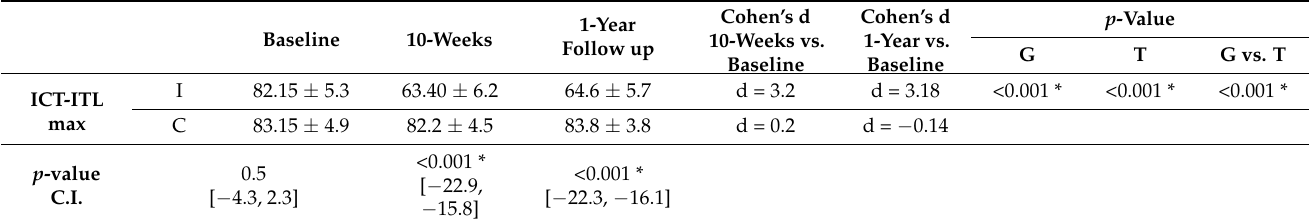
Table 2. The changes in sagittal alignment management outcomes in experimental and control groups vs. time. Kyphotic angle ICT-ITL max = angle of kyphosis between tangents of cervicothoracic junction (ICT) and of thoracolumbar junction (ITL). Values are mean ± standard deviation. G = group; T = time; I = intervention group; C = control group; C.I. [] = 95% confidence interval; p = statistical significance; C.I. [] = 95% confidence interval; Cohen’s d value = d; * indicates statistically significant difference.